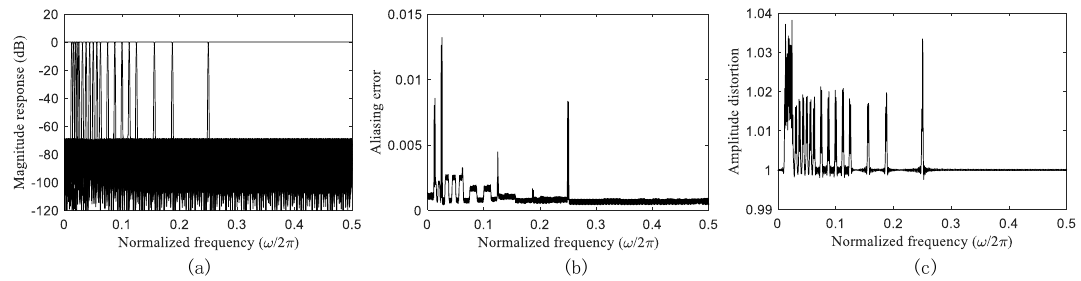
Figure 4. The designed 20-channel linear-phase non-uniform filter banks (LP-NUFBs). ( a ) Magnitude responses of the analysis filters. ( b ) Aliasing error. ( c ) Amplitude